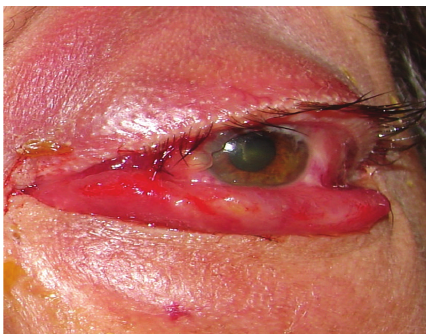
Figure 19: Patient showed an evident quemosis, and orbital inflam- matory involvement of fungal sinusitis, diagnosed as mucormyco- sis.